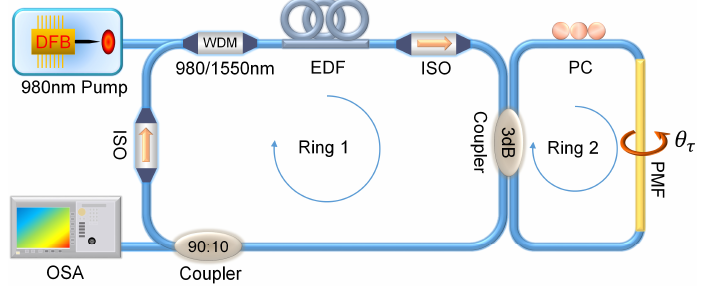
Figure 7. The schematic diagram of the fiber laser torsion sensor (FLTS). WDM: wavelength division multiplexer, EDF: erbium-doped fiber, ISO: isolator.